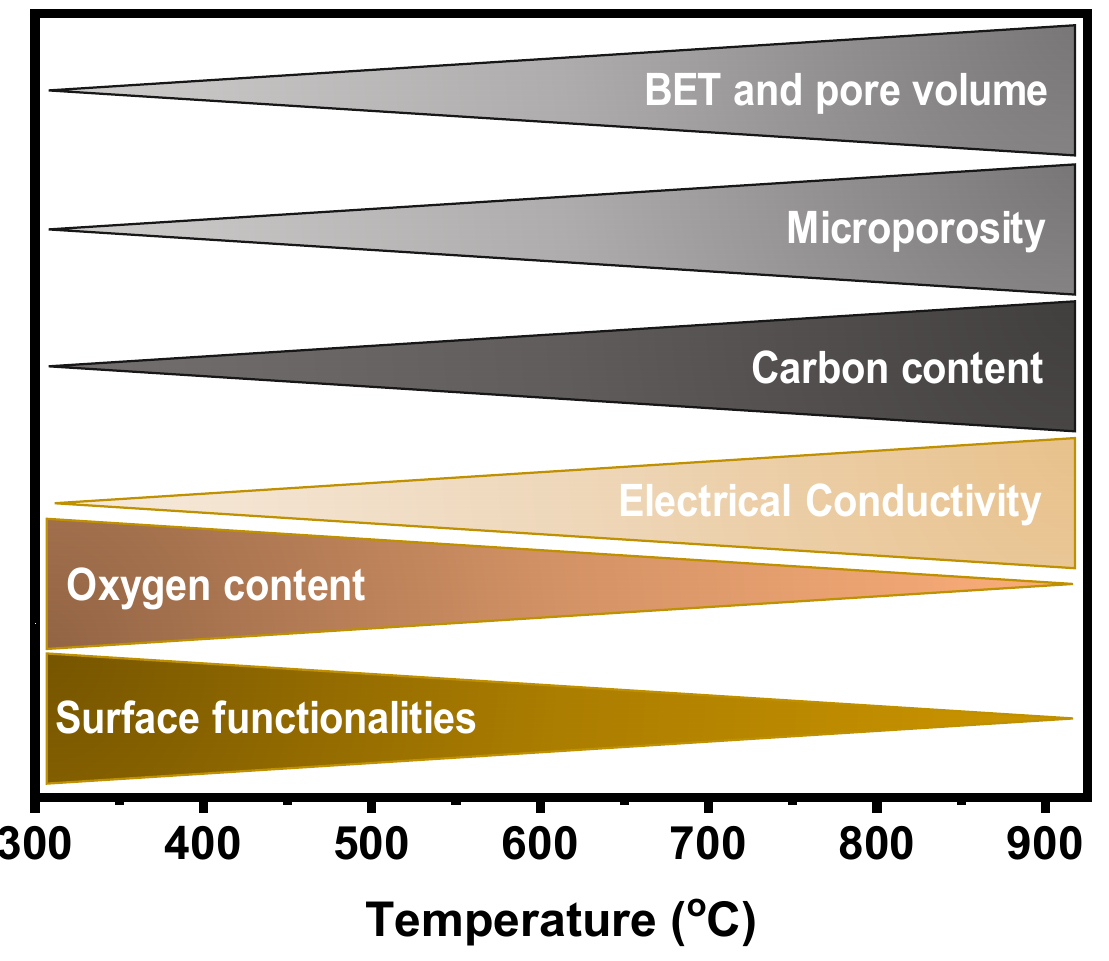
Figure 3. Variation in biochar properties with an increase in pyrolysis temperature conditions.